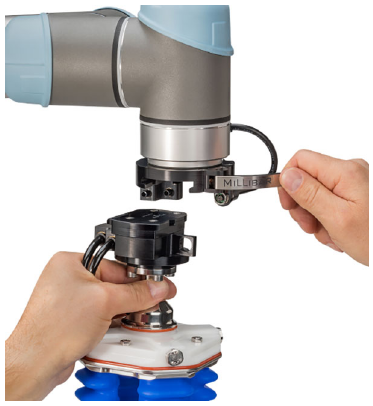
Fig. 2. Manual tool changer